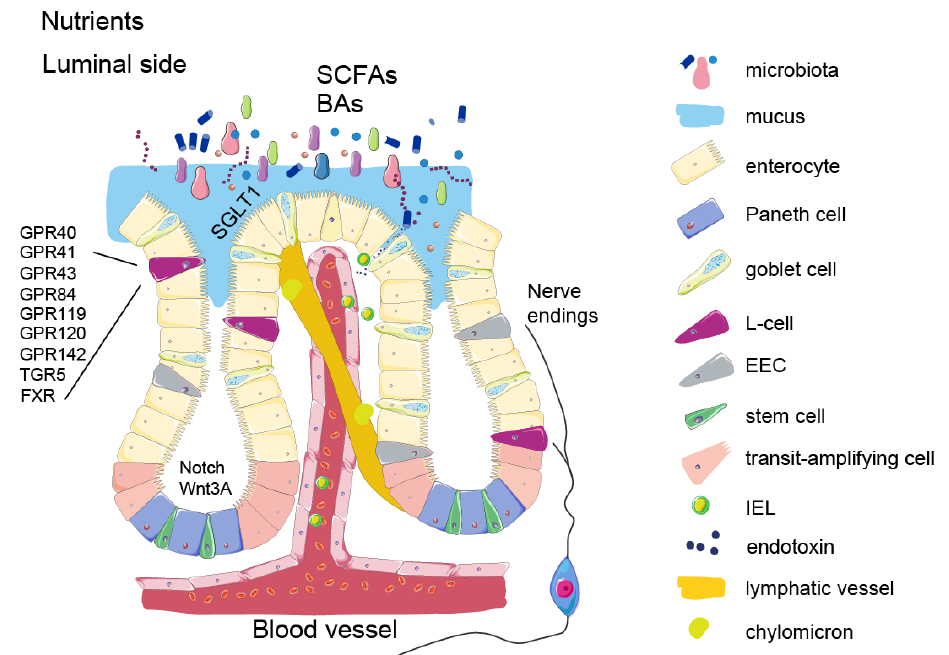
Figure 1. Schematic presentation of intestinal epithelium. Nutrients and metabolites entering the luminal side of the intestine are absorbed by enterocytes. Chylomicrons enters the lymphatic system through lacteals (described in Signaling properties of nutrients section). SCFAs and secondary bile acids are produced in the distal part of the small intestine and in the colon by various microbes (described in Microbial metabolites section). These molecules are sensed through specific receptors on EECs. In this figure, L-cells are presented separately from the other EECs to highlight their particular role in the food intake control and specific receptor expression (described in the Enteroendocrine cells section). Nerve endings originating from the nodose ganglion detect the gut hormone release and transmit the signal along the gut-brain axis to the appetite centers. The figure also shows impaired intestinal barrier function in obesity due to immune cell migration and endotoxin release (described in the Intestinal barrier function section).